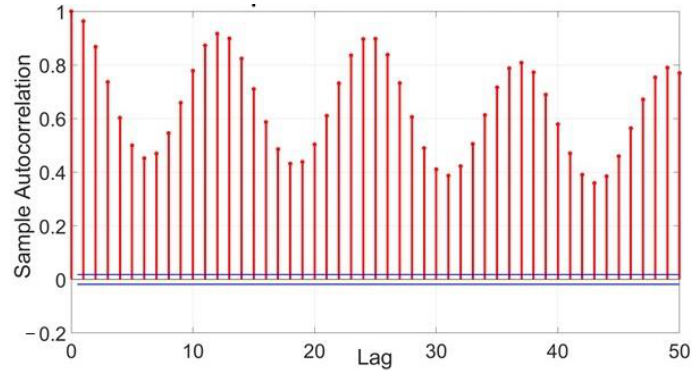
Figure 5. The autocorrelation function for sea level time series.